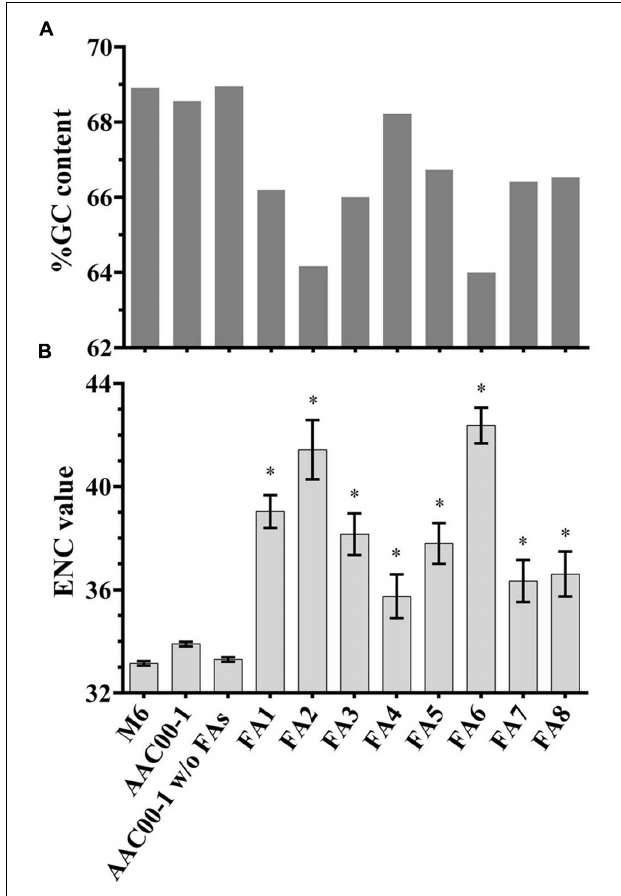
FIGURE 4 | G + C content and ENC value analyses for Acidovorax citrulli M6, AAC00-1, AAC00-1 without the FAs and each of the eight FA fragments. (A) G + C content was calculated using GC-Profile web server; (B) ENC values of predicted ORFs were determined using BioPython package for Python. Data represent average ENC values and standard error. Asterisks above the FAs indicate that the ENC value significantly ( p < 0.05) differs from the ENC value of AAC00-1 without the FAs according to student’s t -test with Bonferroni